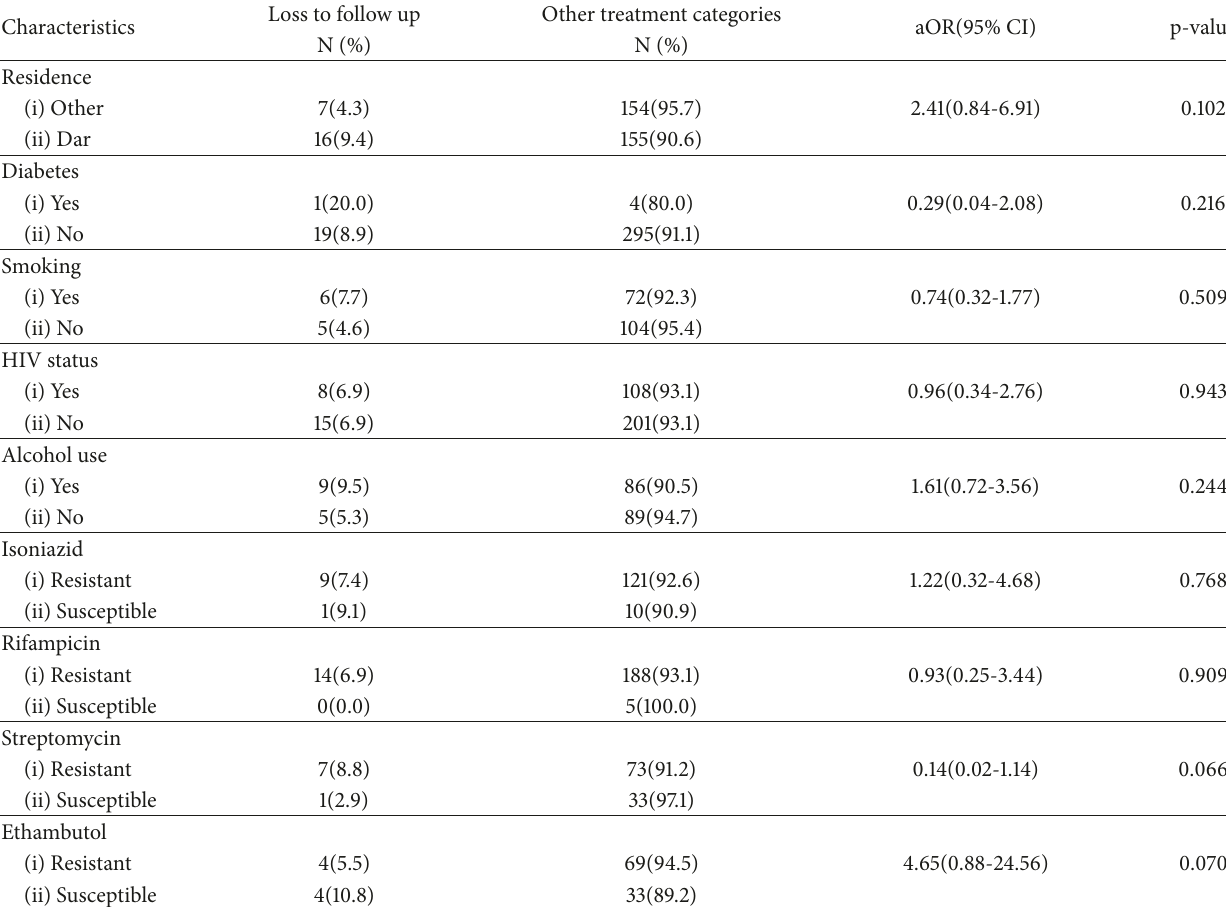
Table 6: Adjusted OR after multivariate analysis for predictors of treatment outcome of loss to follow-up.